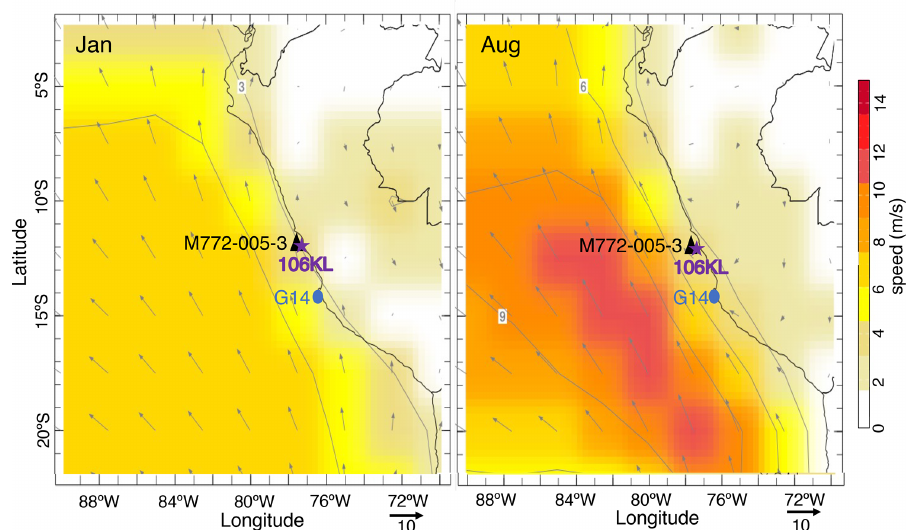
Figure 1. Location of the sampling of the sediment cores M77/2-005-3, 106 KL, and G14. Average wind speed (ms − 1 ) at 1000hPa in January and August (http://iridl.ldeo.columbia.edu, last access: 17 March